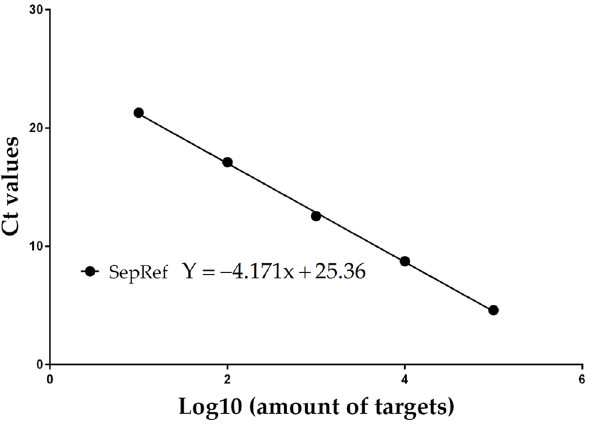
Fig 2. Standard curve for the SepRef (cuttlefish) inhibition assay (R 2 = 0.98).